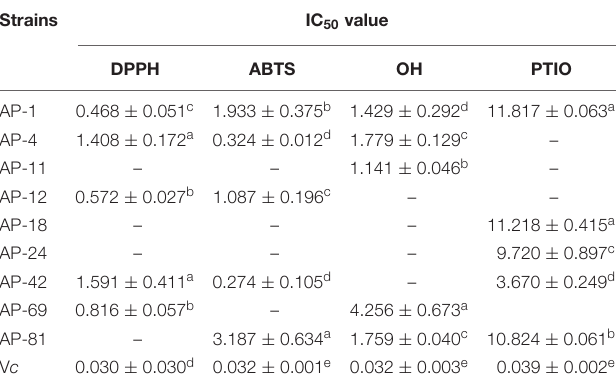
TABLE 3 | IC 50 value from four antioxidant activity assays DPPH, ABTS, OH, and PTIO from the